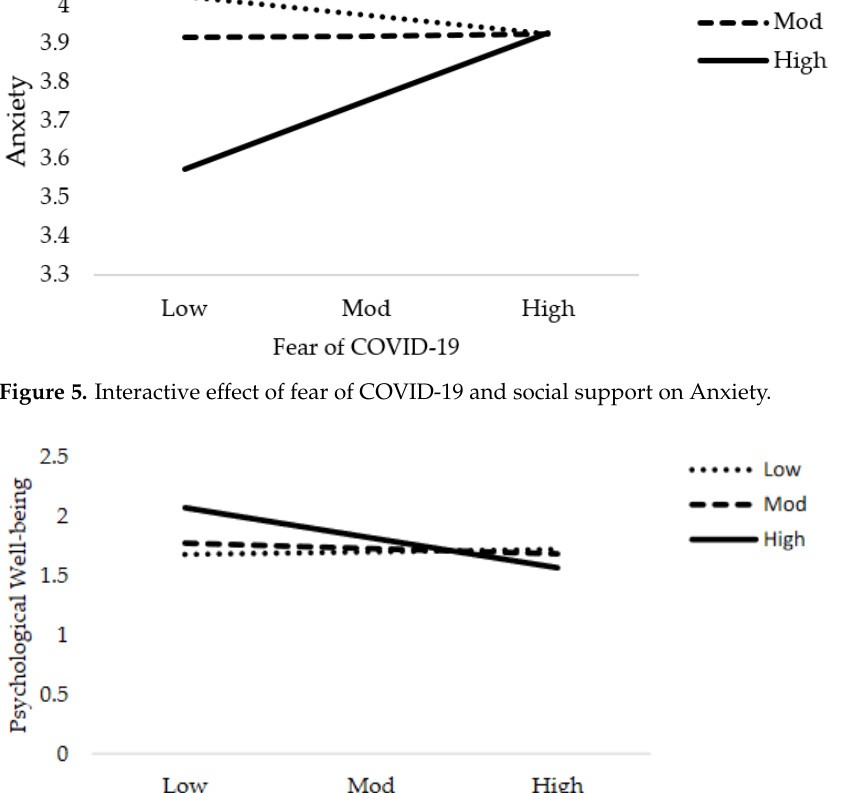
Figure 7. Interactive effect of COVID-19 Exposure and social support on psychological distress.